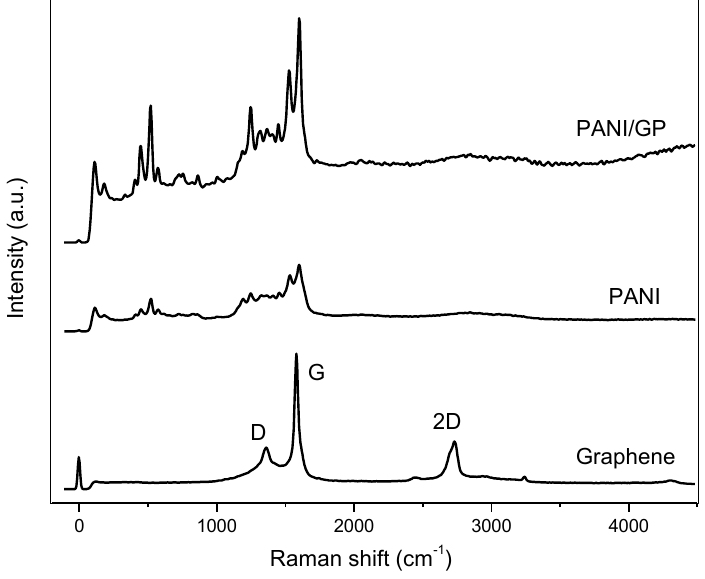
Figure 7. Raman spectra of GP, PANI nanofibers and PANI/GP.